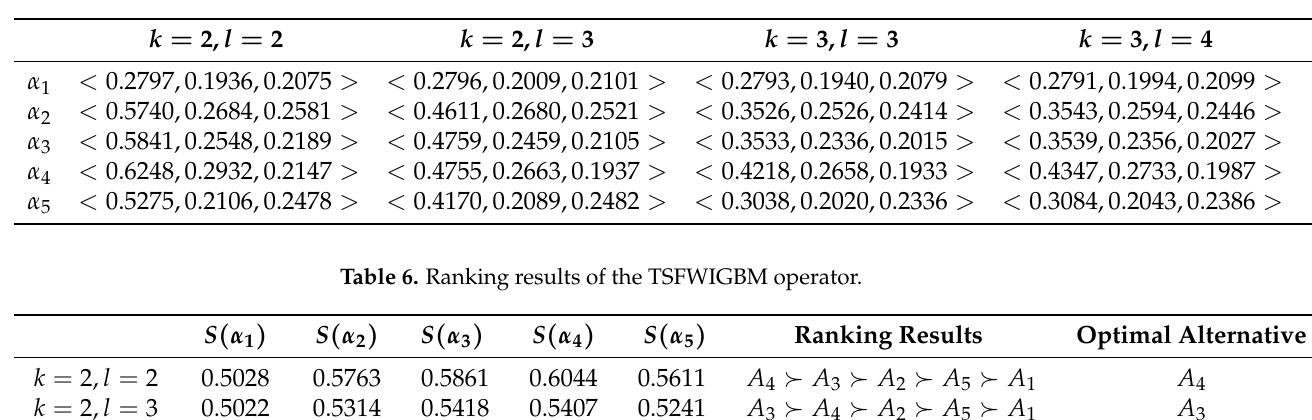
Table 5. Aggregated results of the TSFWIGBM operator.